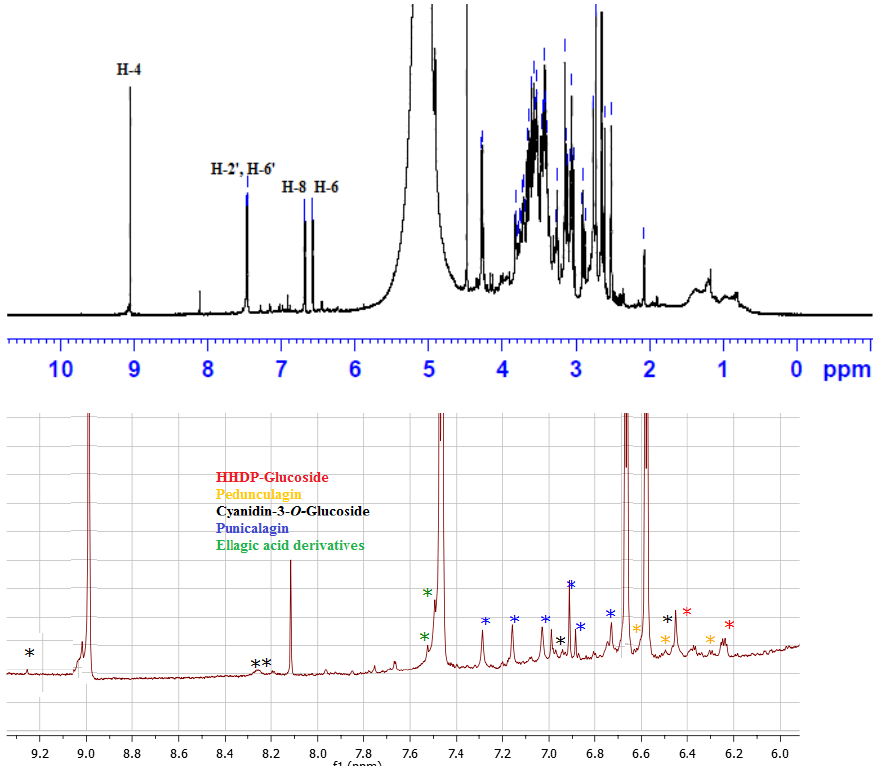
Figure 2. 1 H NMR spectrum of PEAME showing the characteristic peaks for delphinidin-3- O -glucoside ( Top ), the expansion to show the characteristic peaks in the aromatic region (6.00–9.30 ppm) for the other compounds ( bottom ).